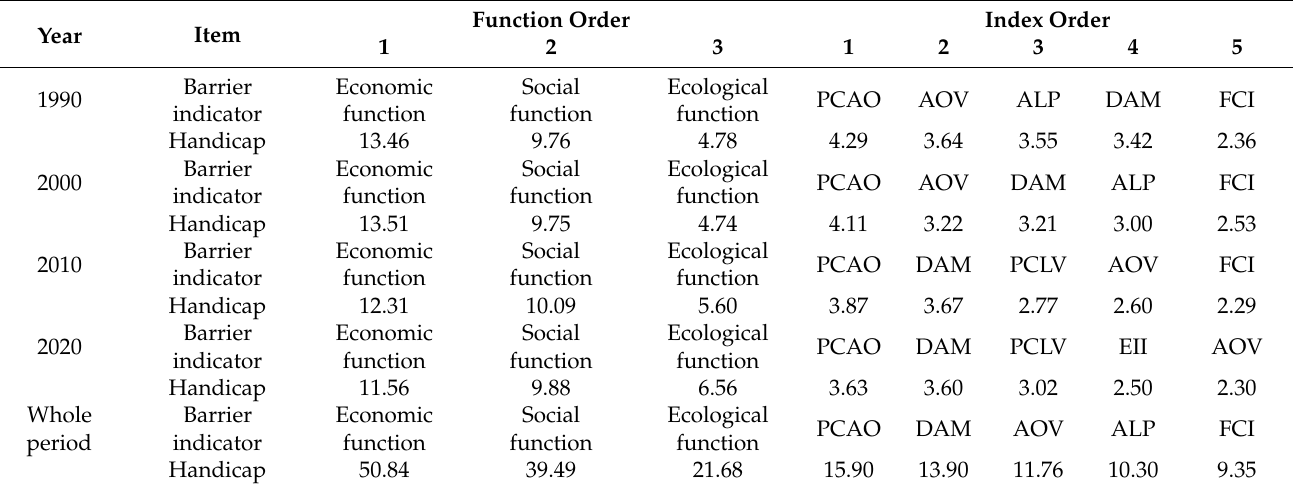
Table 5. Calculated obstacle degrees for factors influencing cultivated-land functions in the black-soil breadbaskets of Jilin Province, Northeast China, from 1990 to